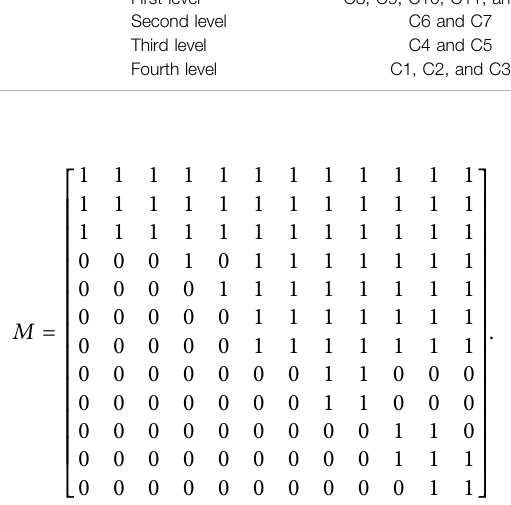
restrictive factors for EV charging piles in the park. The fi rst level is the most direct factor affecting the system, and the fourth level is the most important factor affecting the mode. The higher the level, the deeper the in fl uence is.